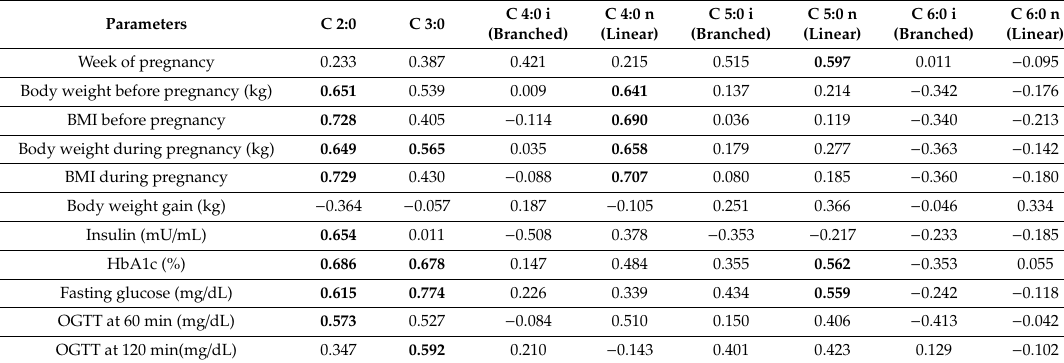
Table 4. Analysis of the relationship between SCFA in the stool and the parameters in the group of overweight and obese pregnant women (OW).